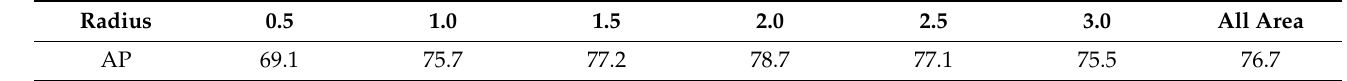
Table 4. Model performance of using different radii in the context-aware strategy.